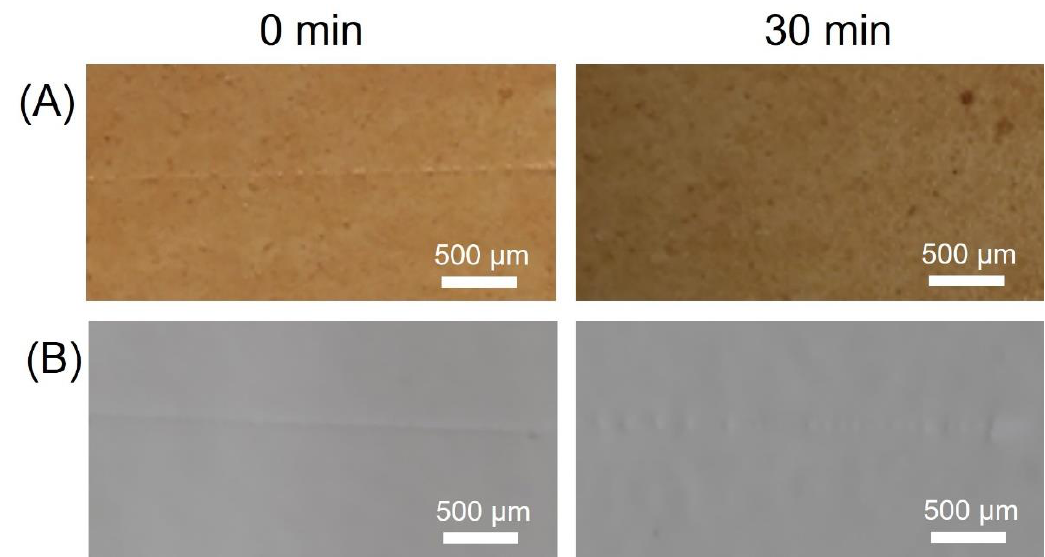
Figure 2. Images taken during scratch healing tests of healable PU ( A ) and control PU ( B ) coated textile after 0 and 30 min at 90 °C.